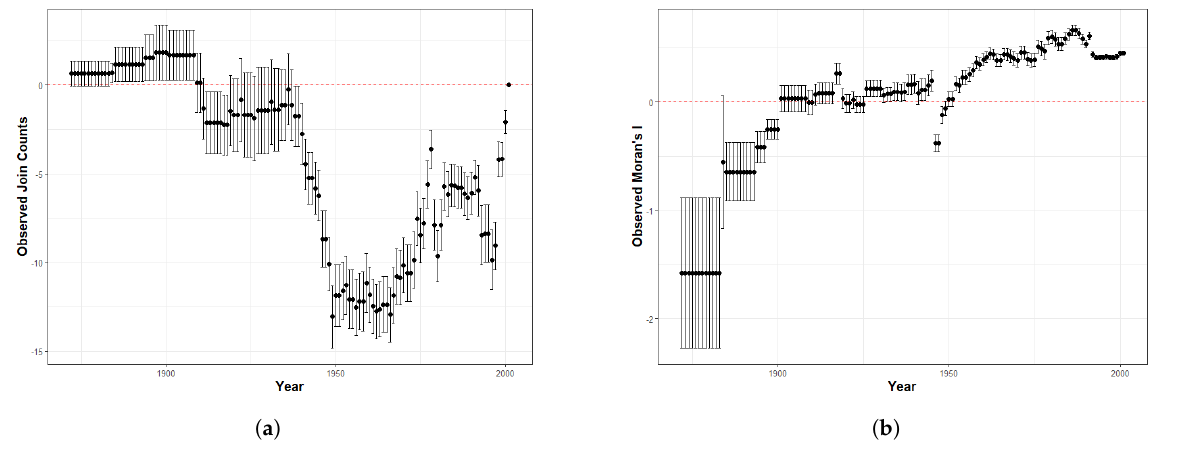
Figure A1. Results from the two autocorrelation diagnostics for the democratic survival application: ( a ) join count and ( b ) Moran’s